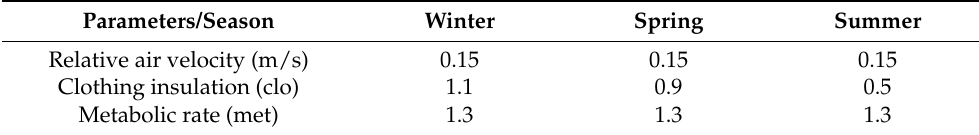
Table 2. Thermal comfort level analysis inputs of mosque scenarios.